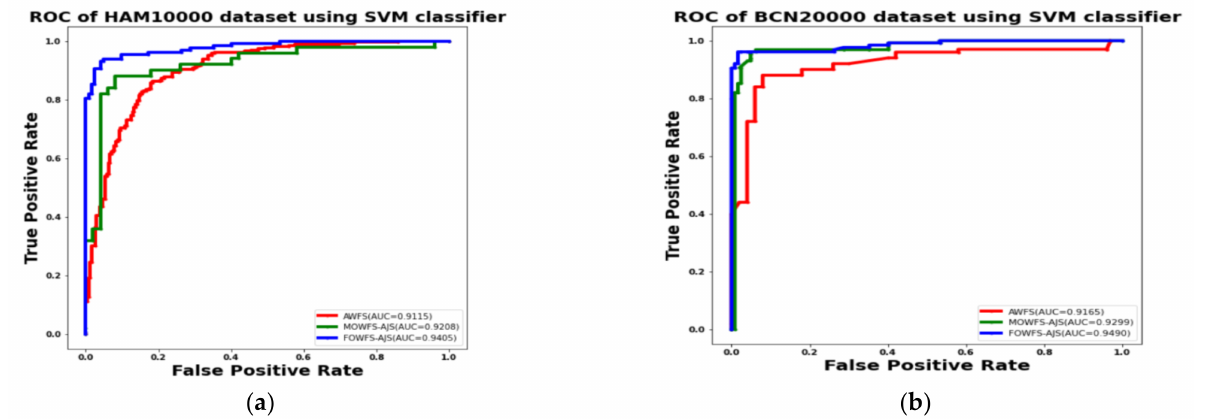
Figure 13. ROC using SVM classifier for ( a ) HAM 10000 dataset and ( b ) BCN 20000 dataset.